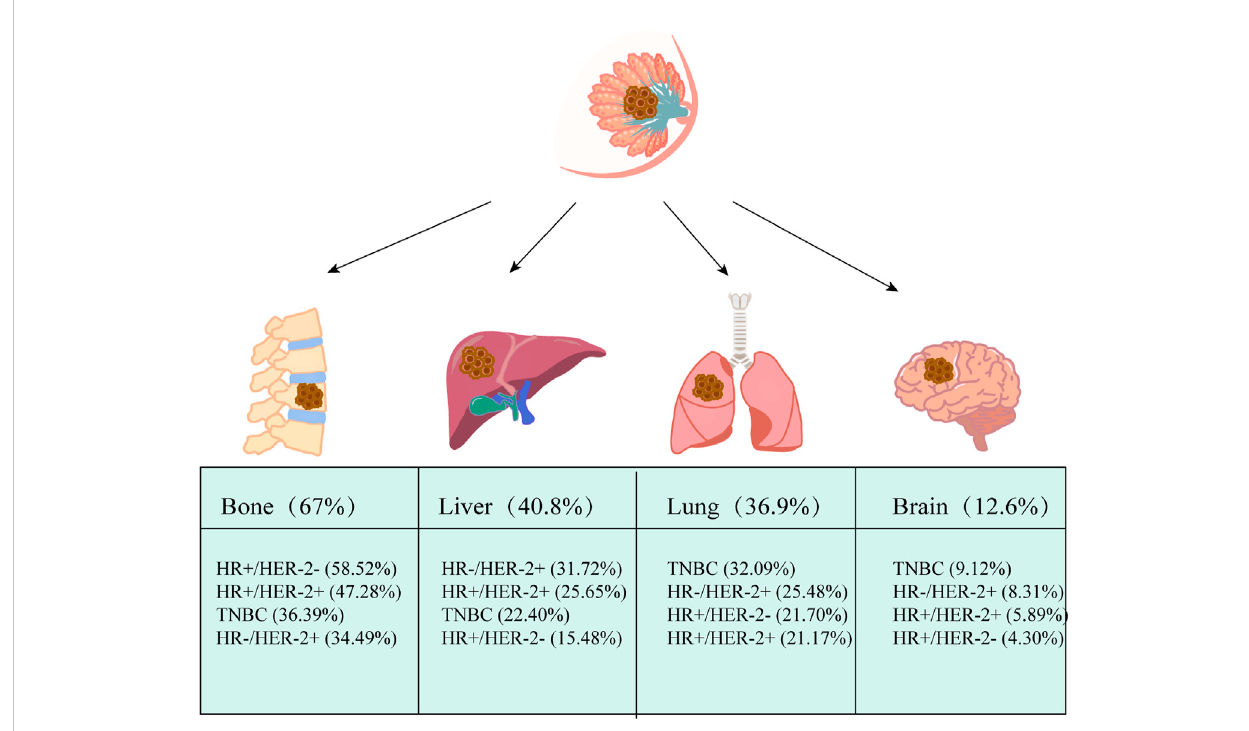
FIGURE 1 Common distant metastasis in breast cancer. The most common distant metastatic organ for breast cancer is the bone, with the liver coming in second,followedbythelungandbrain.Basedonhormonereceptor(HR)andhumanepidermalgrowthfactorreceptor2(HER2)status,breastcancerwas classi fi ed into four subtypes: hormone receptor (HR) +/human epidermal growth factor receptor 2 (HER2) − , HR+/HER2+, HR − /HER2+ and triple- negative (TN). Based on data from Surveillance, Epidemiology, and End Results Program (SEER) (2010 – 2013), The pathologic subtypes of 243,896 invasive breast cancers differed markedly in metastatic behavior at distant metastatic sites, with triple-negative breast cancer (TNBC) and HR+/ HER2+ being more likely to have brain metastases. The data comes from (Wu et al.,